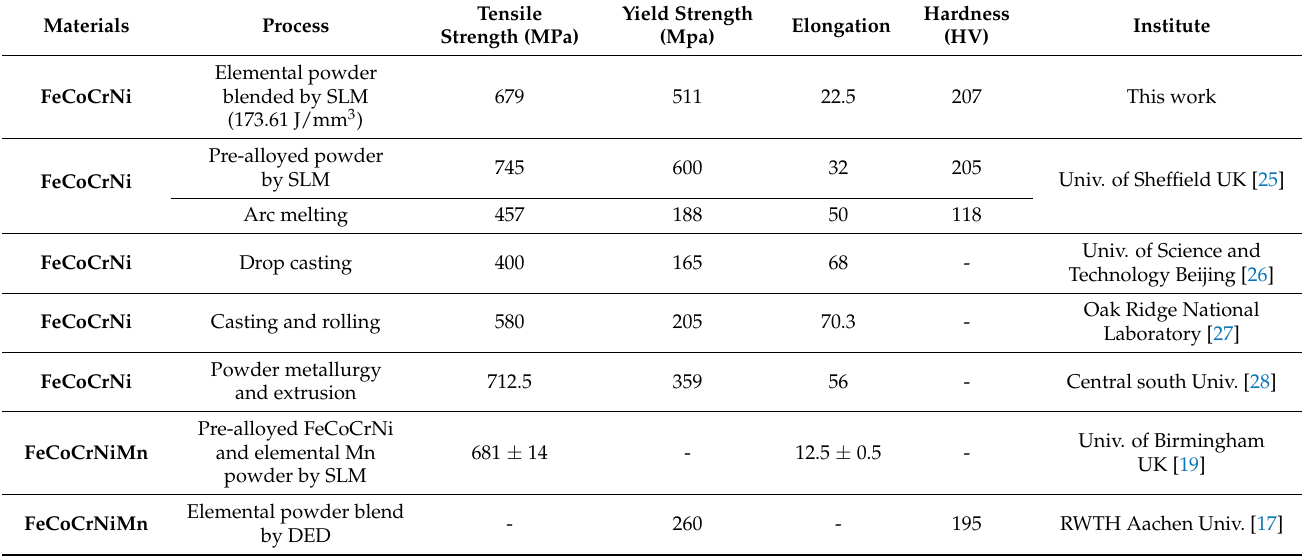
Table 4. The mechanical properties of FeCoCrNi-related alloys reported in recent